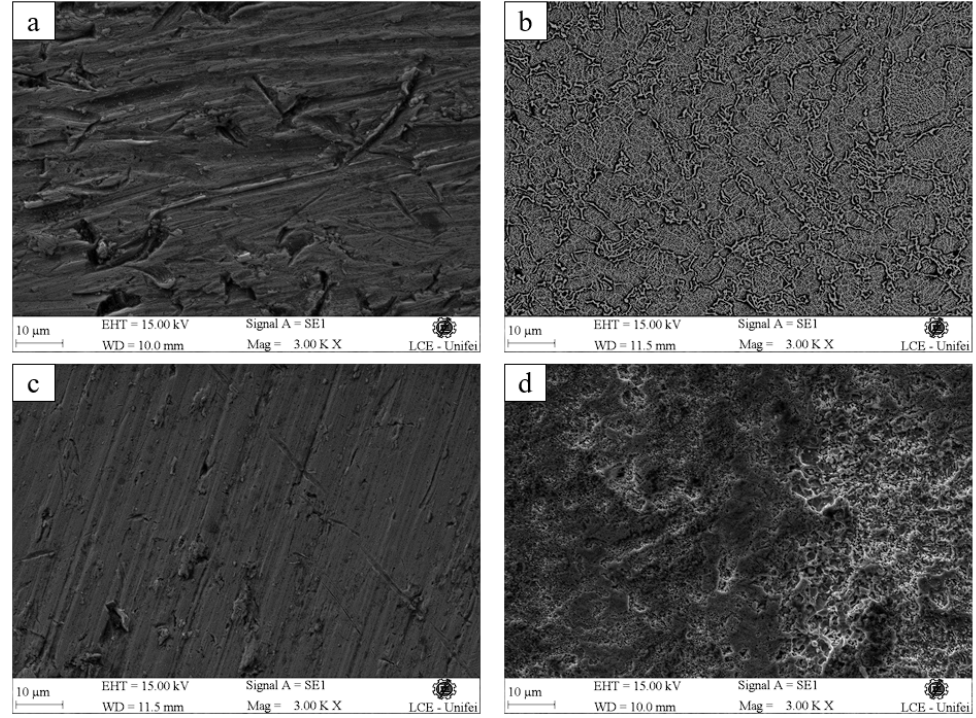
Figure 2. Topography of cp-Ti and Ti-30Ta samples: ( a ) cp-Ti sample after polish treatment; ( b ) cp-Ti after the acid etching process; ( c ) Ti-30Ta sample with polished surface treatment; ( d ) Ti-30Ta sample with acid etching